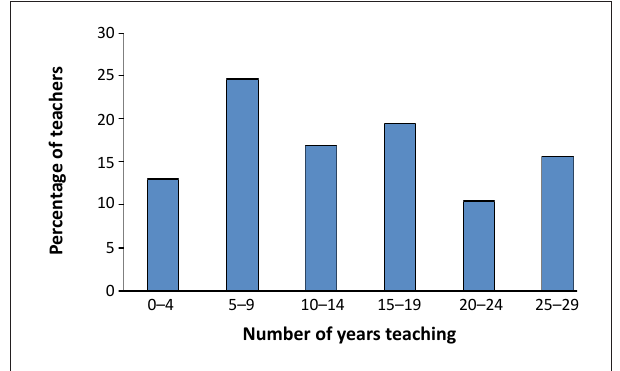
FIGURE 3: Teaching experience of responding teachers.